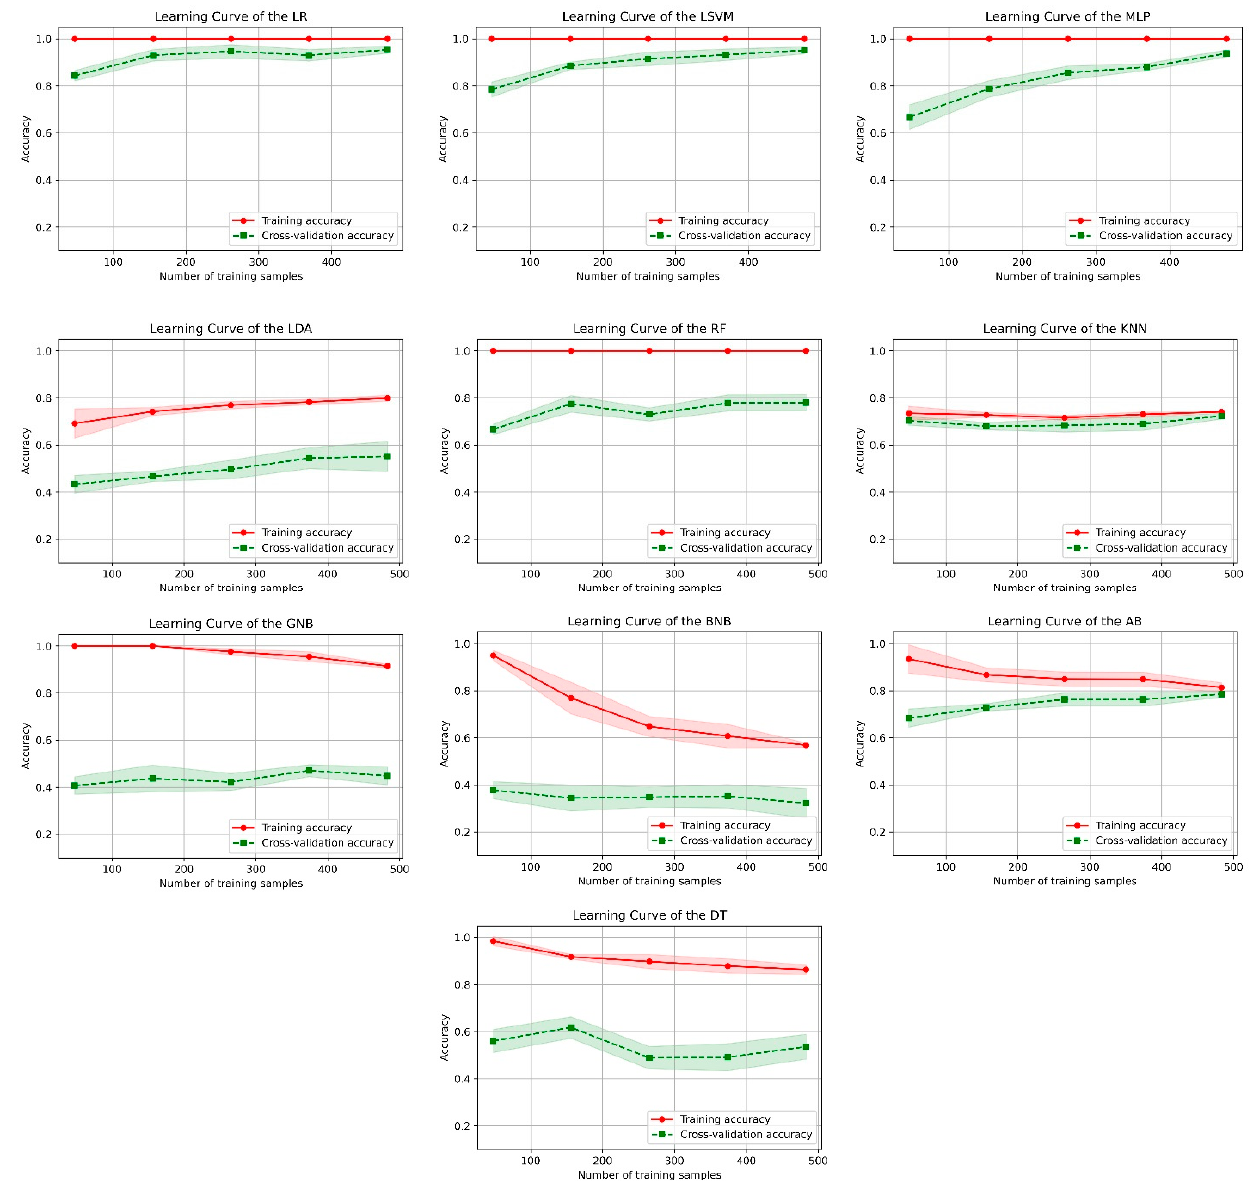
Figure 3. Learning curves of machine learning classifiers.